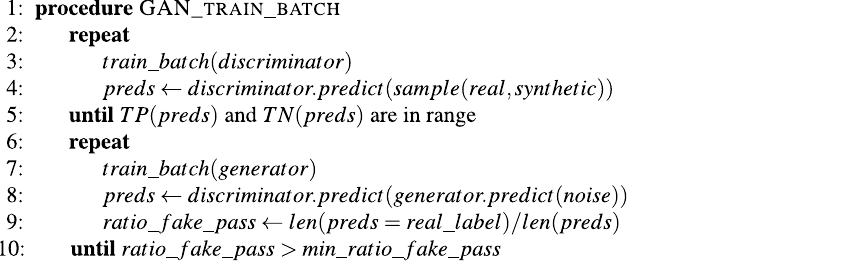
Figure 3. Enhanced GAN training procedure with adaptive